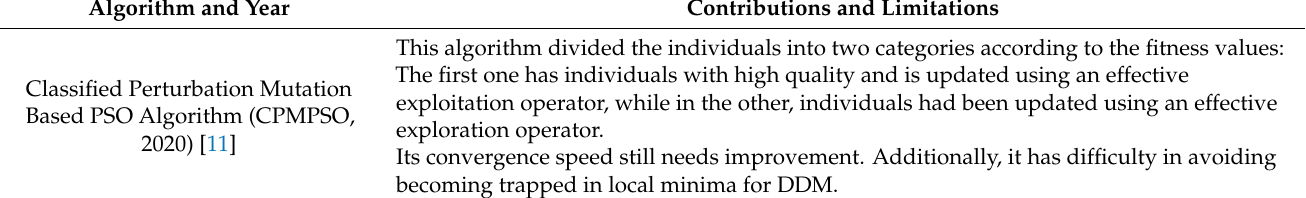
Table 1. Reviews of some studied algorithms for the PIP of different PV